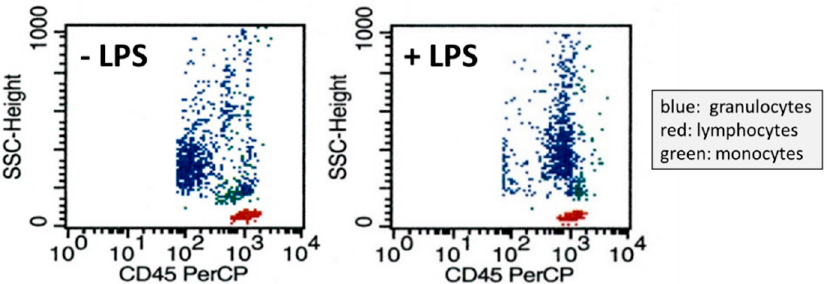
Figure 1. Original diagrams from FACS analysis showing the CD45 surface expression of leucocytes subsequent to 4 h incubation with vehicle ( left ) and lipopolysaccharide (LPS, right ). Shown are fluorescence of leucocytes caused by peridinin–chlorophyll–protein complex marked antibodies directed against CD45 on the abscissa and the sideward scatter on the ordinate. Note the marked increase in CD45 on the surface of granulocytes in LPS-treated cells.